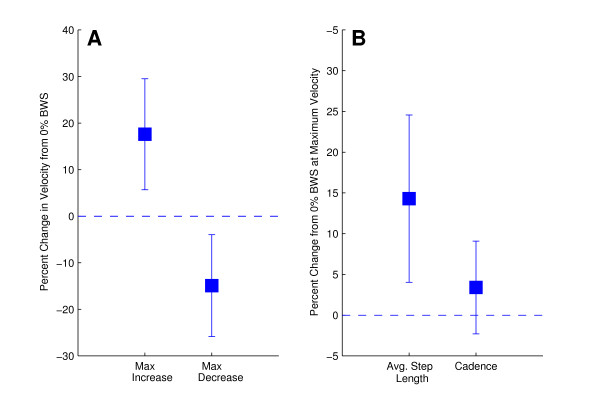
Plot A indicates the maximum percent increase and maximum percent decrease in velocity that post-stroke subjects attained regardless of level of support. Plot B examines the percent change in average step length and cadence recorded at a subject's maximum speed for the post-stroke subjects.